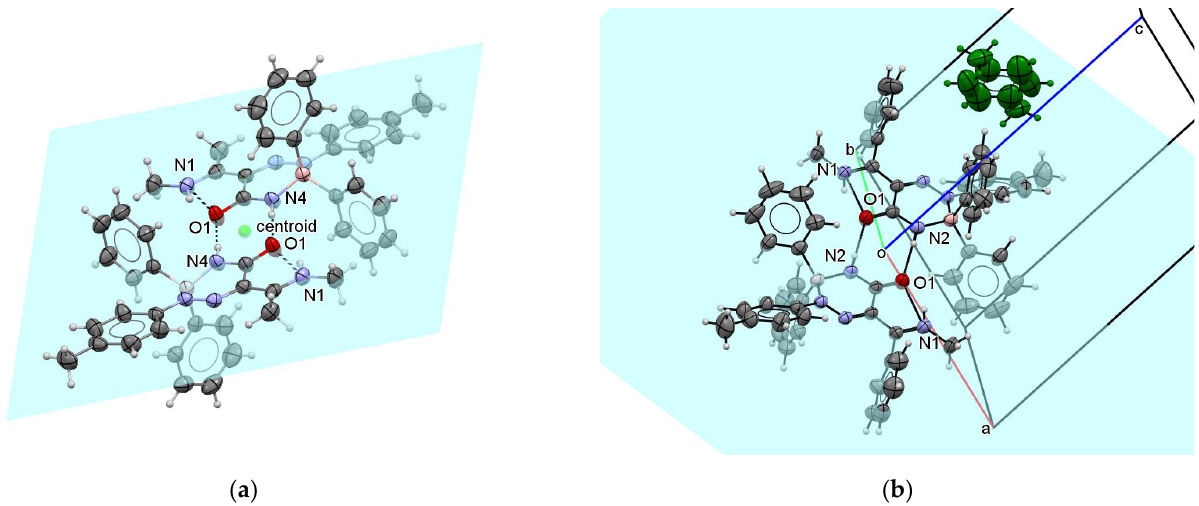
Figure 11. ORTEP diagram of the dimer forming the basis of the triazaborinone 5c crystal ( a ); and ORTEP diagram of the triazaborinone 5d crystal ( b ).